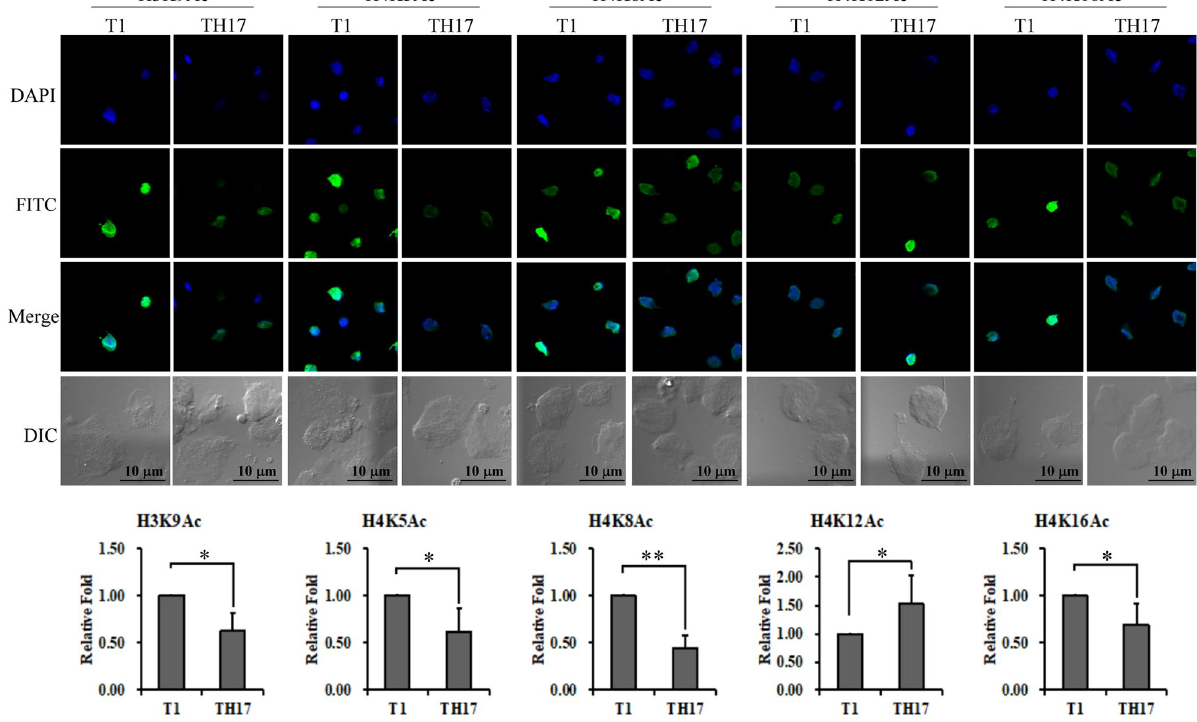
PLOS NeglectedTropical Diseases | https://doi.org/10.1371/journal.pntd.0011016 January 3,